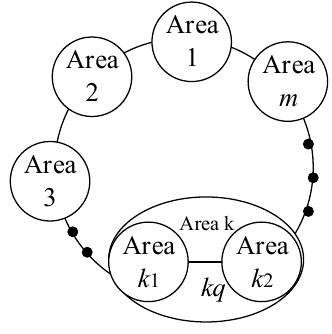
Figure 5. Diagram of a redivided ring